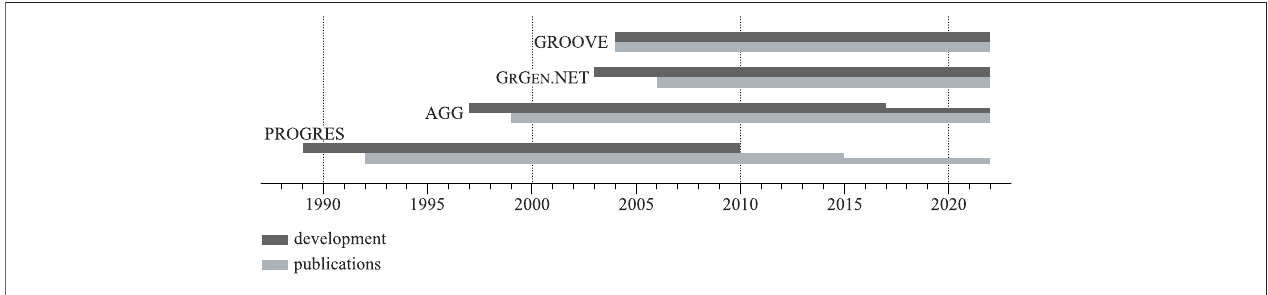
FIGURE9| Notallofthepresentedframeworksarestillcontinuedandmaintained.This fi guregivesanoverviewofthetimesofdevelopmentandreferenceanduse in research projects. Smaller bars indicate that only small updates were published or references only list the tool without using